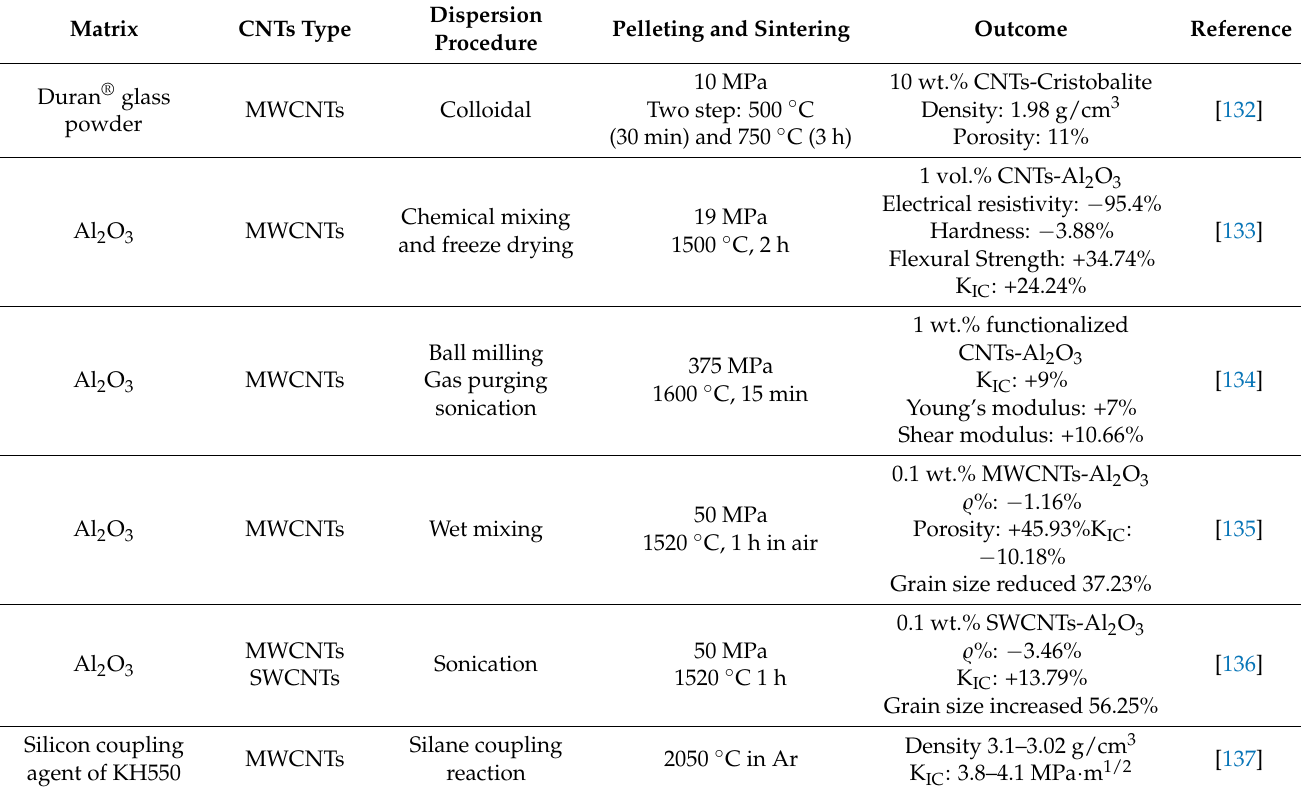
Table 7. Previous work on CNTs-CMCs through PLS